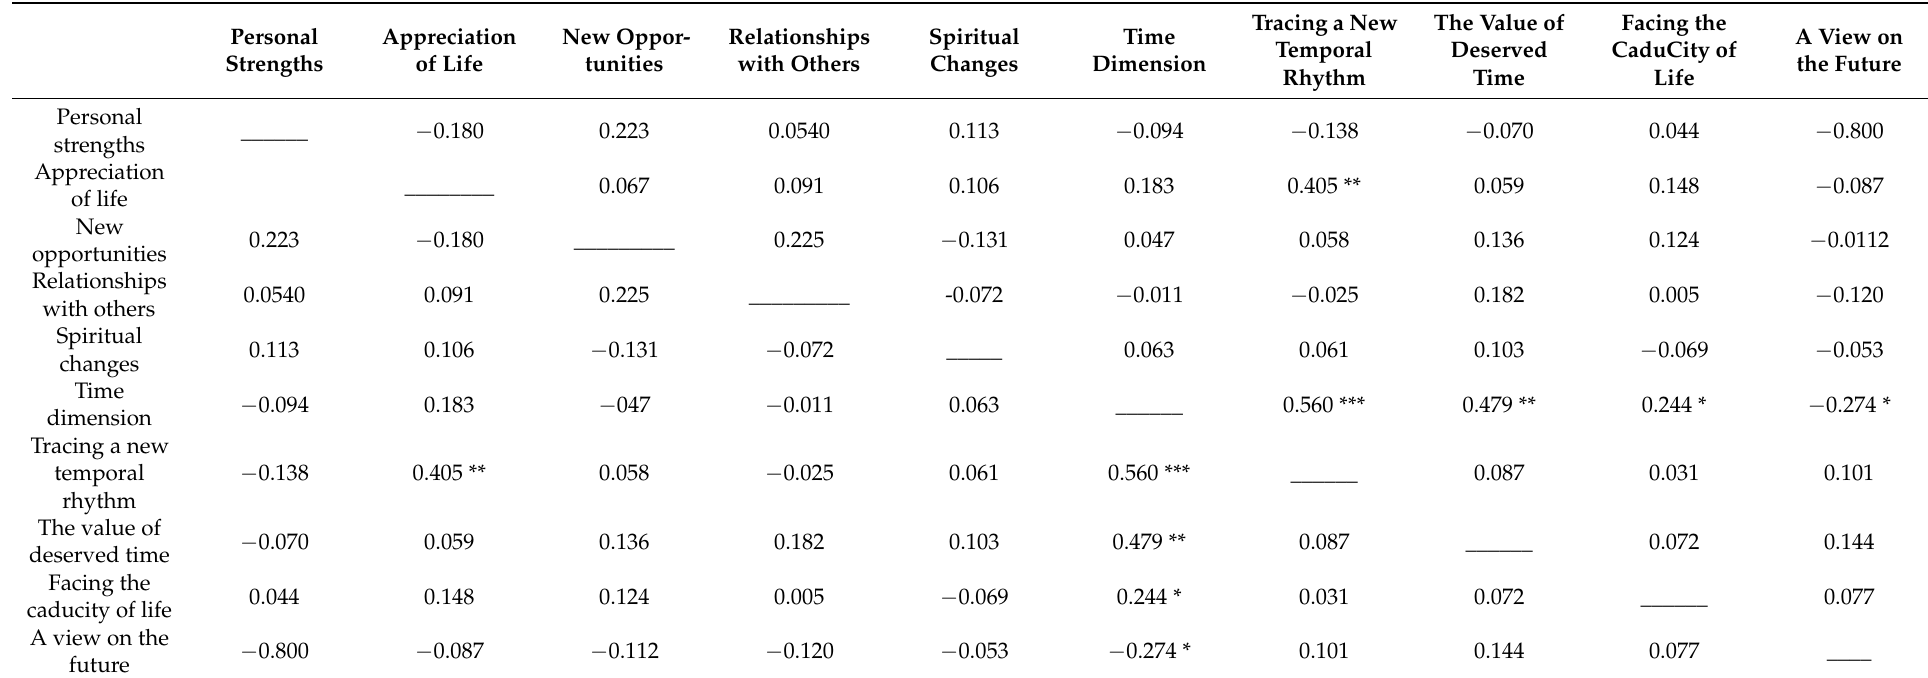
Table 3. Non-parametric correlations with Spearman’s rho test among the five factors of PTG (Tedeschi and Calhoun, 1006) and the time dimension and its four emerging